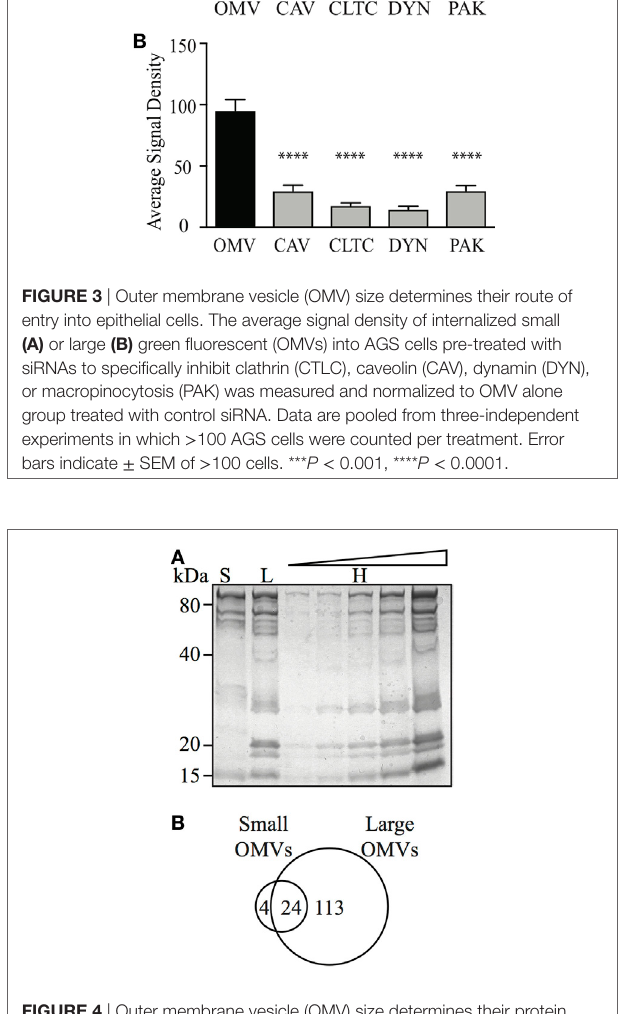
FigUre 4 | Outer membrane vesicle (OMV) size determines their protein content and composition. (a) Coomassie blue-stained polyacrylamide gel showing protein profiles of small (S), large (L), and heterogeneous (H) OMVs, the latter loaded in increasing concentration. (B) Venn diagram of proteins detected within small and large OMVs. A total of 137 proteins were detected in large OMVs and 28 proteins were detected in small OMVs. There were 24 proteins found in both large and small OMV populations.